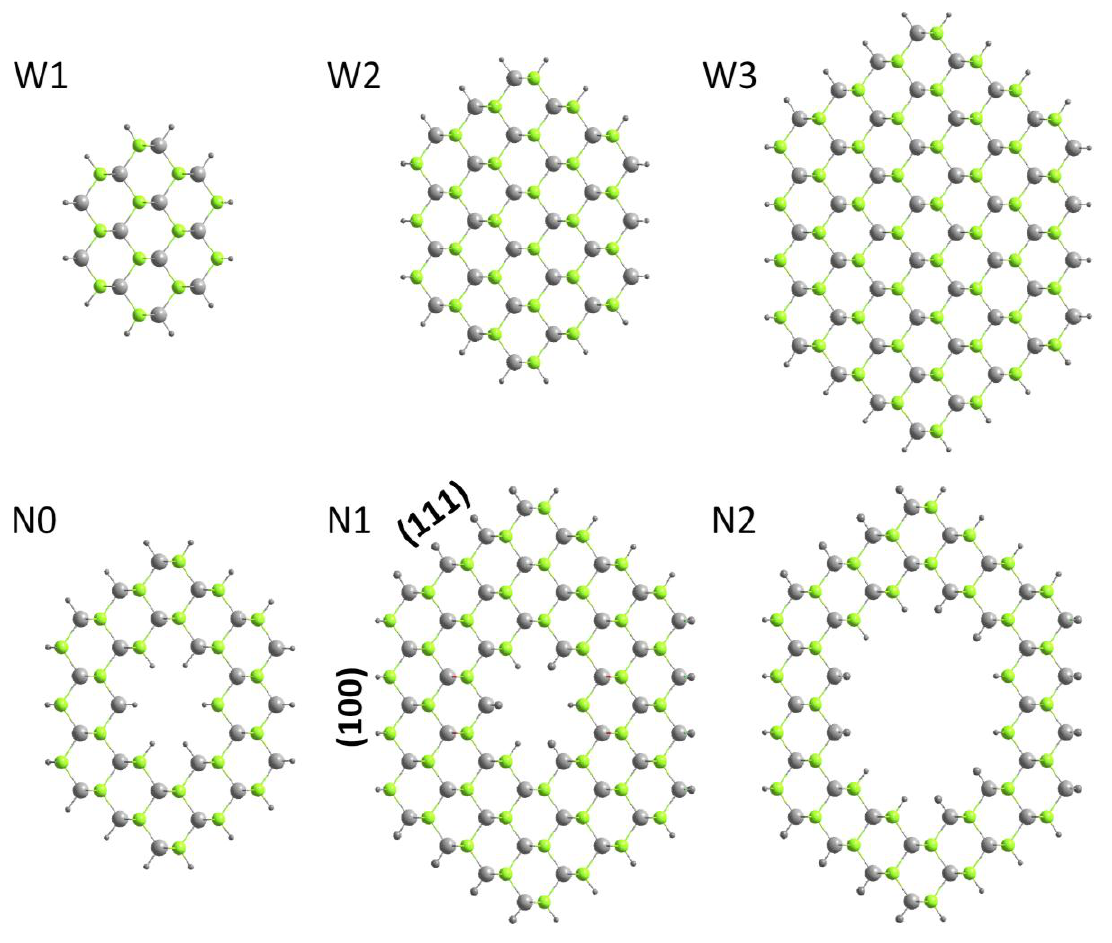
Figure 2. Top view of ZnSe nanowires (W1–W3) and nanotubes (N0–N2). The grey and green spheres represent Zn and Se atoms, while the outer and inner black spheres are pseudo hydrogen